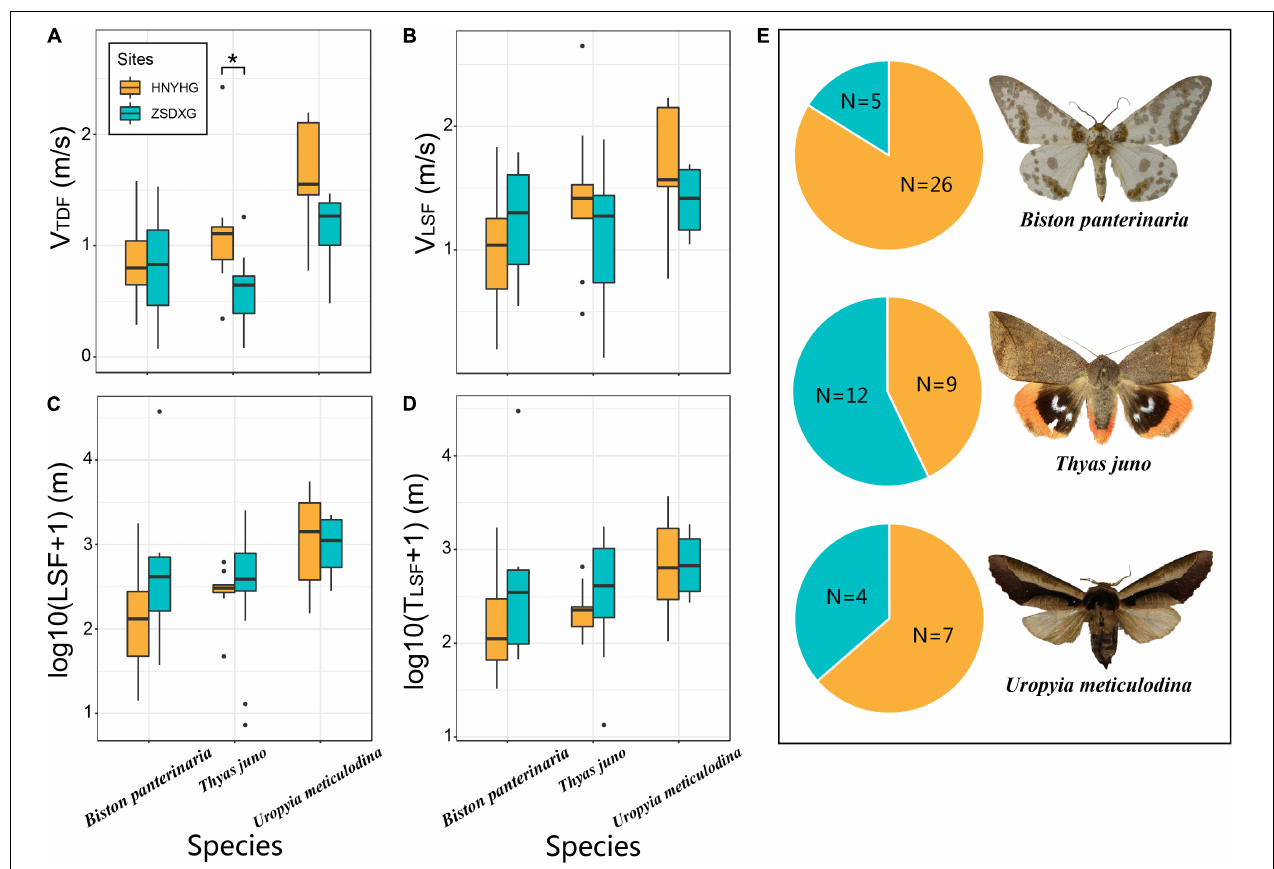
FIGURE 3 | Comparison of flight ability of common species ( Biston panterinaria , Thyas juno , and Uropyia meticulodina ) between HNYHG and ZSDXG. (A–D) Box plot of comparing the flight capabilities of common species captured from HNYHG and ZSDXG. The difference between the samples is calculated by the Wilcoxon rank-sum test of the two-tailed hypothesis ( ∗ : 0 . 01 ≤ p < 0 . 05, ** : 0 . 001 ≤ p < 0 . 01, *** : p < 0 . 001), only the samples with significant differences between HNYHG and ZSDXG are marked with *, ** or *** in this figure. (E) Sample size of three species between two sampling sites [species photo source: T. juno (license holder: Unspecified, University of Oslo, Natural History Museum), U. meticulodina (license holder: Unspecified), and Biston panterinaria (license holder: Axel Hausmann, SNSB, Zoologische Staatssammlung Muenchen)].